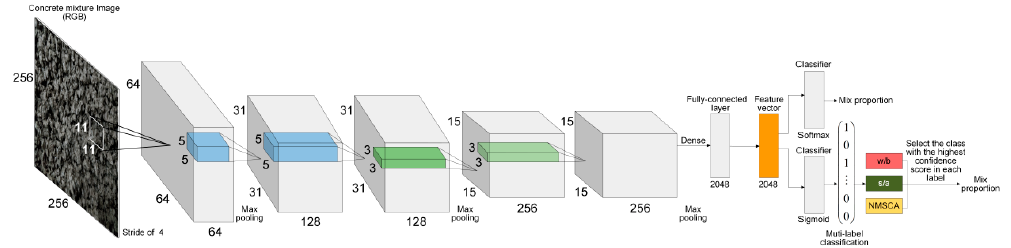
Figure 2. Structure of Net- Ⅱ (above) and Net- Ⅳ (below).